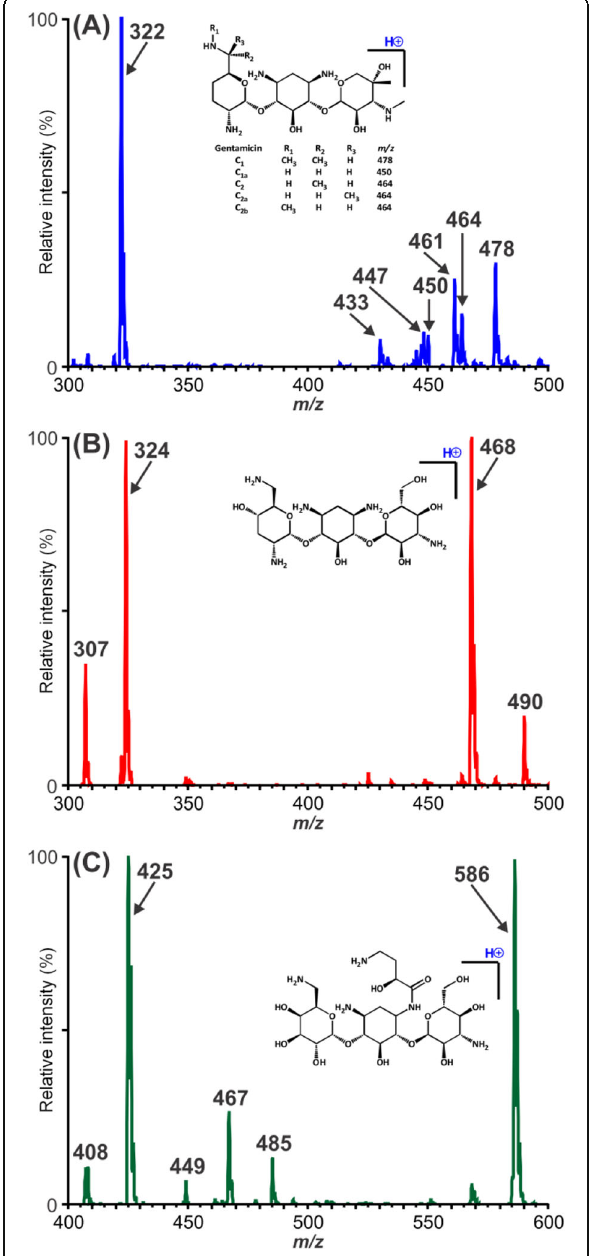
Fig. 1 Positive-ion MS 1 electrospray-ionization spectra acquired from a sample of gentamicin ( a ), tobramycin ( b ), and amikacin ( c ) under low-energy in-source fragmentation conditions (declustering potential 50